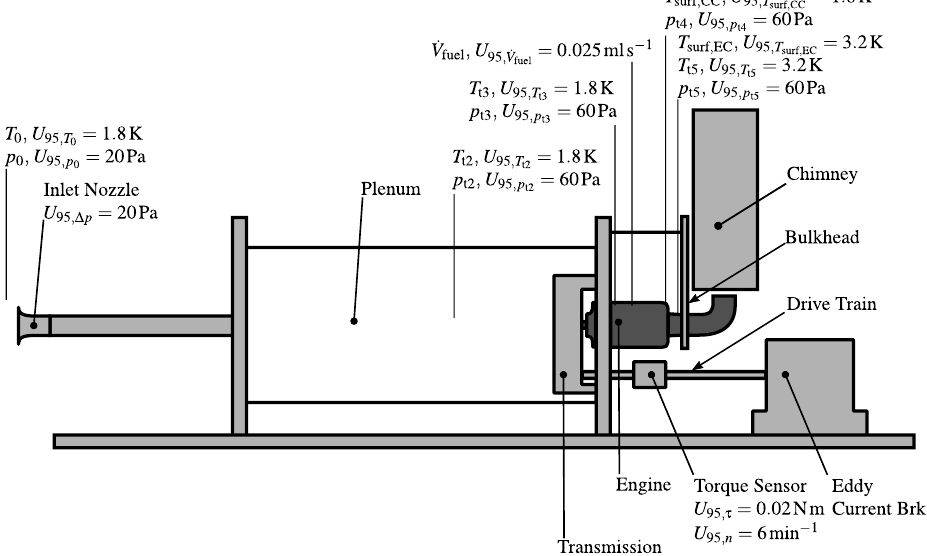
Figure 8. Experimental setup, instrumentation, and systematic part of sensor